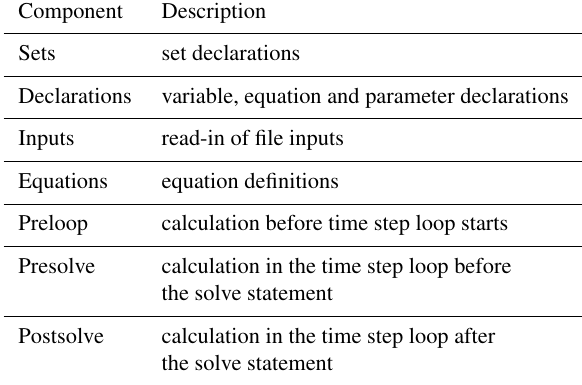
Table A1. Module